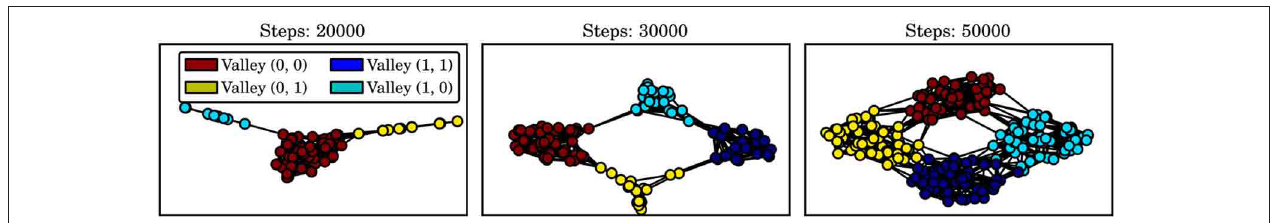
FIGURE 4 | Two-dimensional embedding (determined using Isomap) of the learned transition graphs. Densely connected subgraphs correspond to the four valleys.